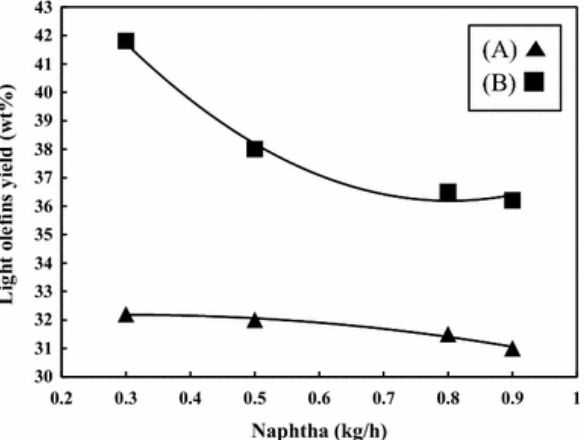
Figure 15. Light olefins yield depending on the naphtha feed rate in fluidized catalytic cracking over steamed micro-spherical catalyst prepared with: ( A ) commercial ZSM-5 (filled triangle); and ( B ) ZSM-5 synthesized with crystalline seed (filled square) (reaction condition: naphtha/steam ratio ( wt / wt ) = 4, contact time = 2 s, catalyst/oil = 50, reactor temperature = 680 °C, regeneration temperature = 720 °C) [106]. Copyright Springer, 2016.